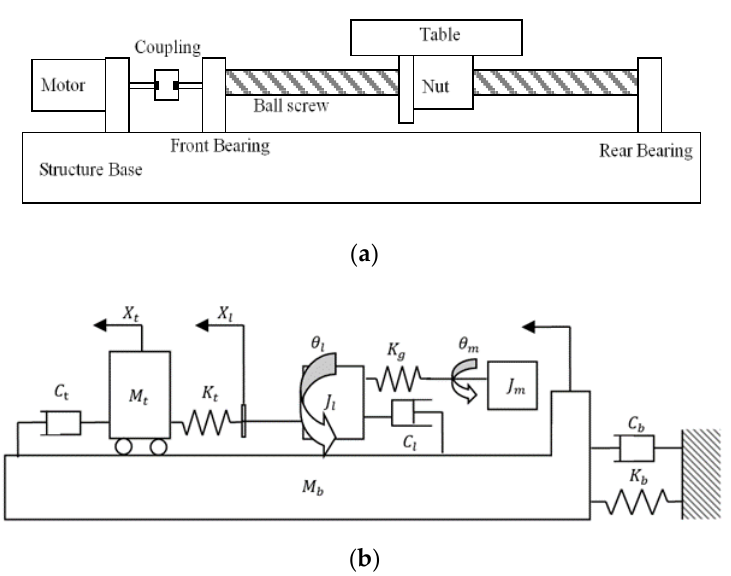
Figure 1. The feed drive system. ( a ) The schematic of the feed drive system. ( b ) The 2 DOF diagram of the feed drive system.